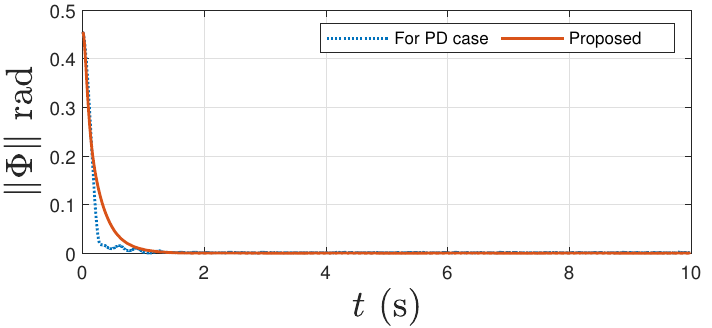
Figure 12. Norm of attitude tracking error for the proposed controller and the PD-type controller in [44].